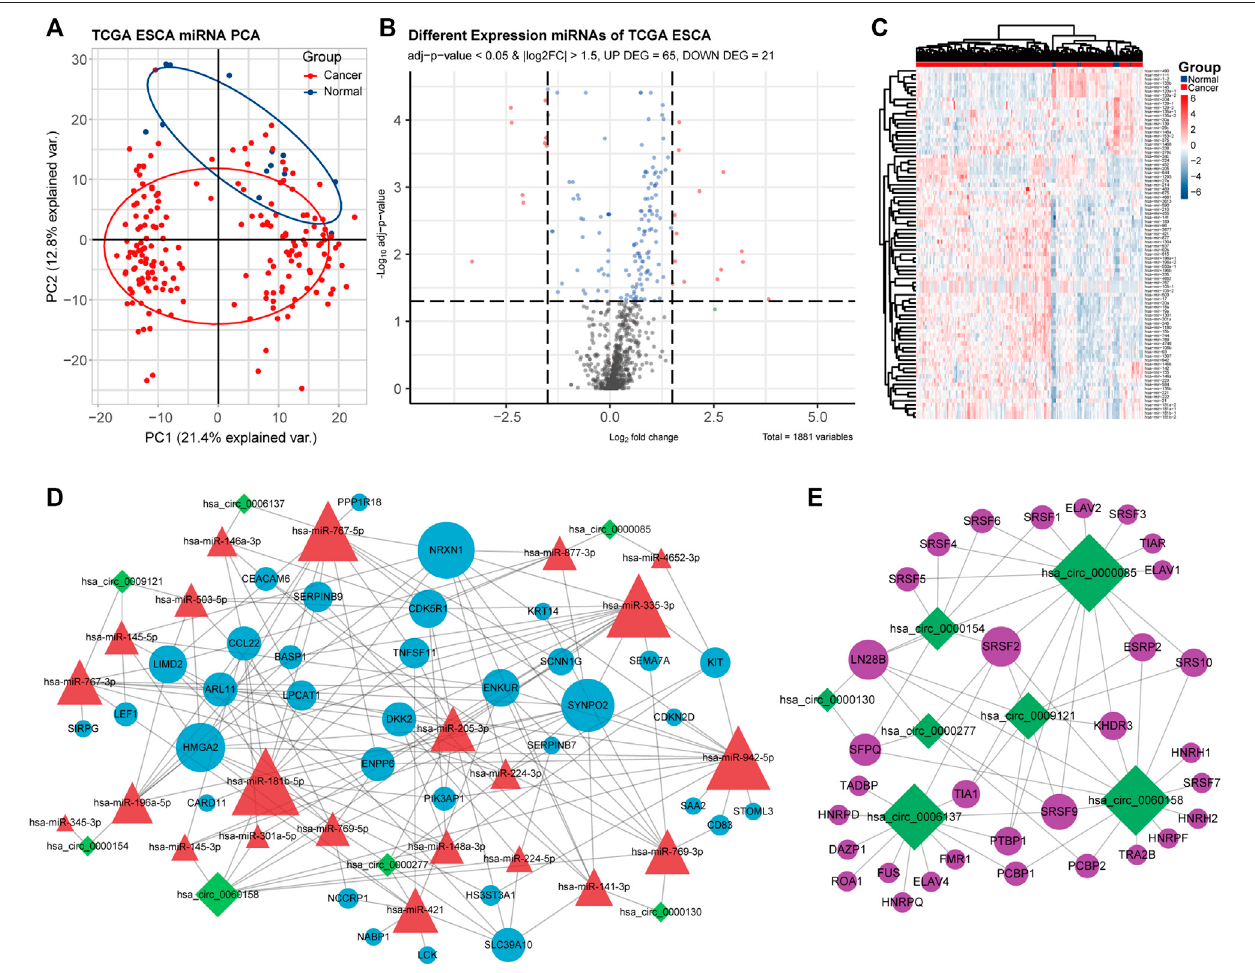
FIGURE 3 | Identi fi cation of differentially expressed miRNAs (DEmiRNAs) in ECA, the ceRNA network, and the circRNA – RNA binding protein (RBP) network. (A) PCA of miRNA expression between ECA and normal groups in TCGA cohort. (B) Volcano plot of the distributions of all DEmiRNAs in TCGA cohort. (C) Hierarchical clusteringheatmap ofdysregulatedmiRNAs betweenECA and theadjacent normaltissuesinTCGA cohort. (D) CeRNAnetworkofcircRNA – miRNA – mRNAinECA; (E) circRNA – RBP binding network.